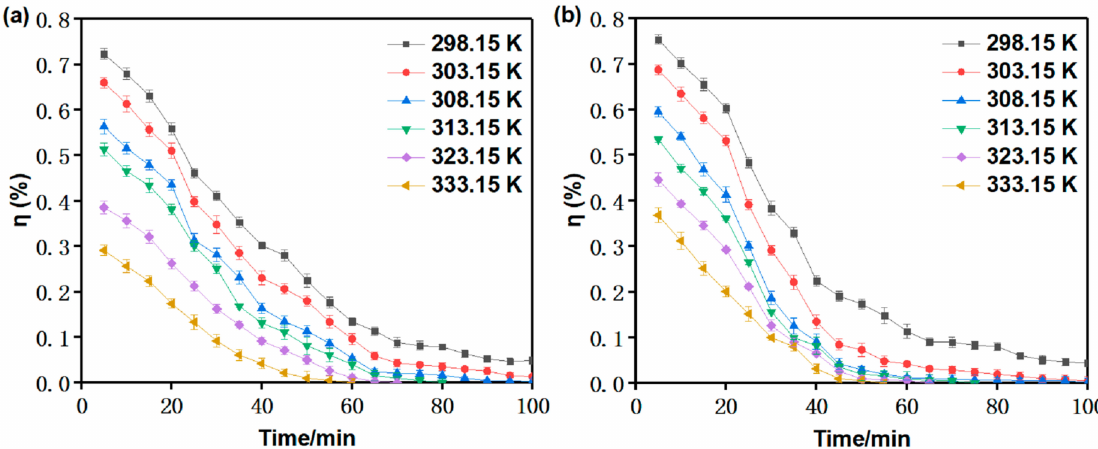
Figure 4. The influence of absorption temperature on the absorptivity for ( a ) DCM and ( b ) benzene (C DCM = 20,000 mg · m − 3